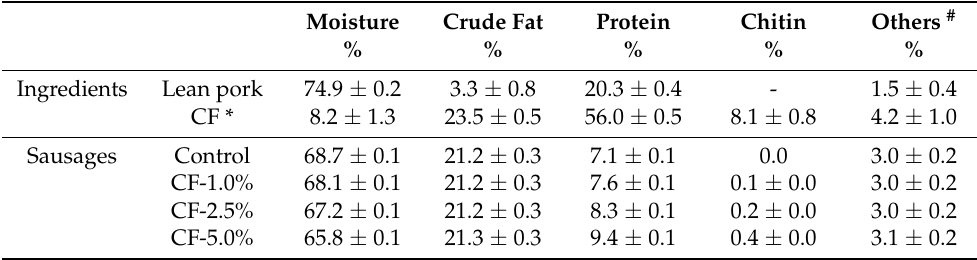
Table 2. Measured proximate composition of the major raw ingredients (lean pork and cricket flour) and calculated proximate composition of